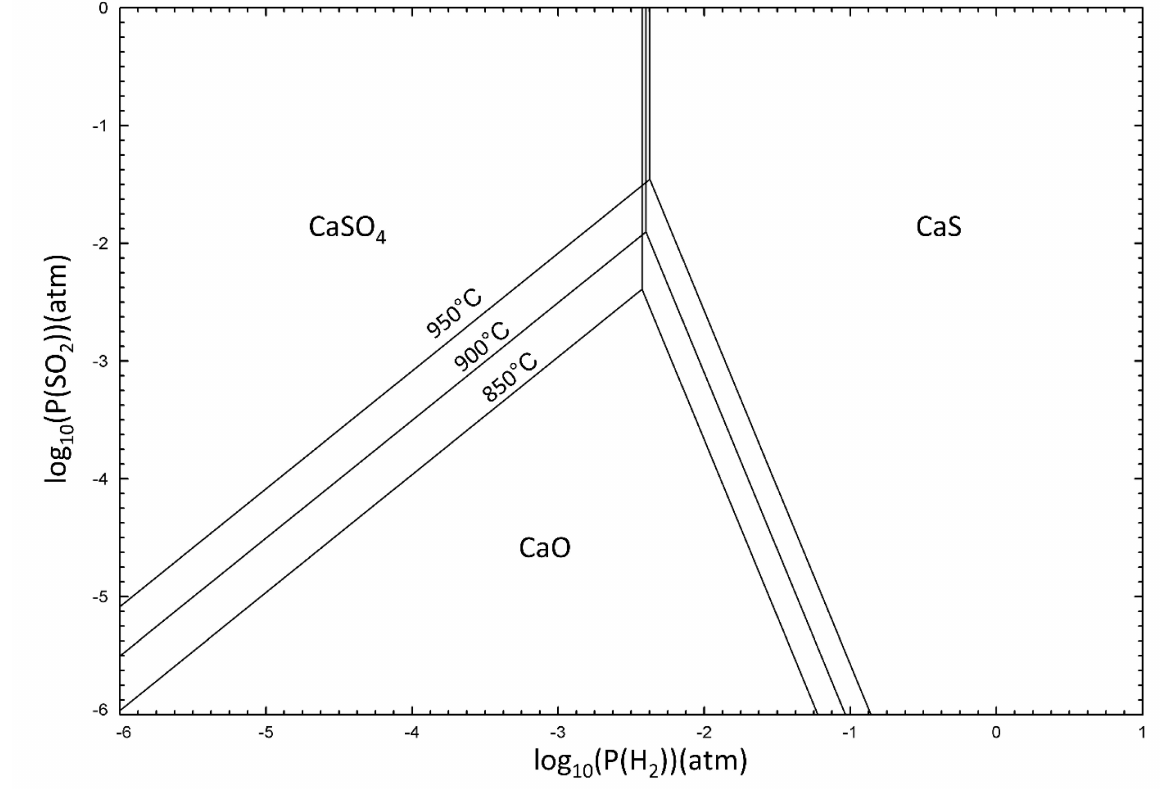
Figure 2. Ca-S-O-H diagram of stable solid phases at different H 2 and SO 2 partial pressure at different temperatures with a constant partial pressure of steam of